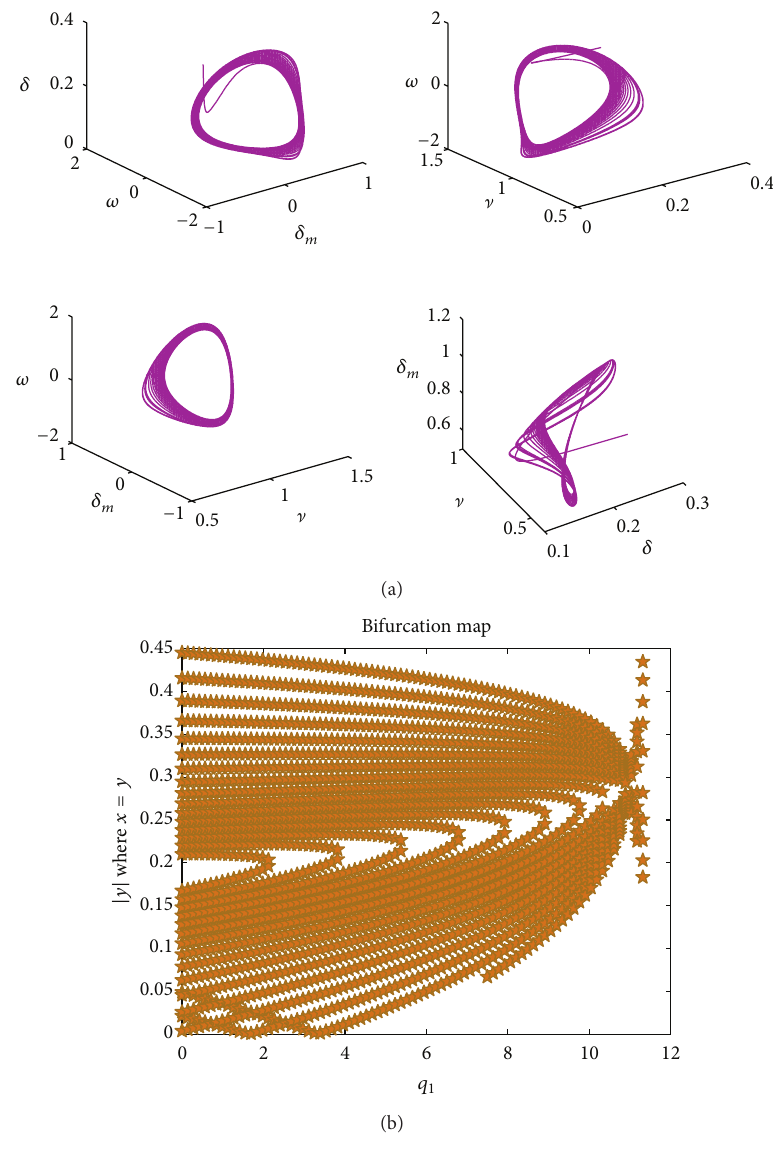
Figure 1: (a) The 3D trajectory in the integer order power system. (b) The related bifurcation diagram of the parameter 𝑄 1